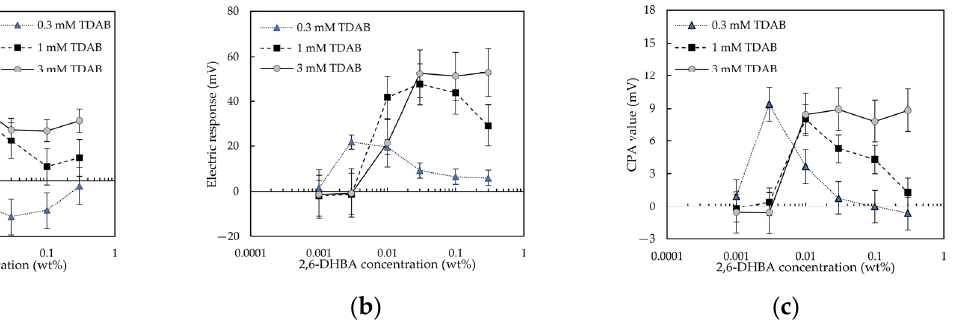
Figure 7. 2,6–DHBA-concentration-effect curves, for 100 mM caffeine, obtained using the taste sensor with the lipid/poly- mer membrane (0.3, 1, 3 mM TDAB): ( a ) change in reference potential; ( b ) change in electric response; and ( c ) change in CPA value. The error bar expresses the SD, of the data, of n = 4 (electrode) × 4 (rotation) = 16